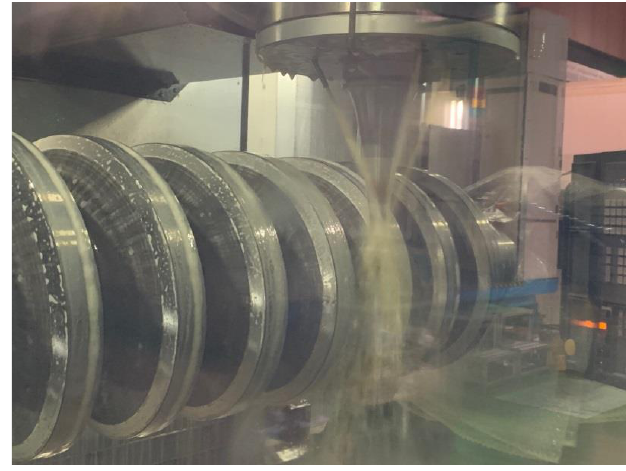
Figure 7. Manufacturing of worm on universal CNC machine tool. Table 2. Cutting conditions for semi-finishing and finishing operations in worm manufacturing. Semi-Finishing Finishing